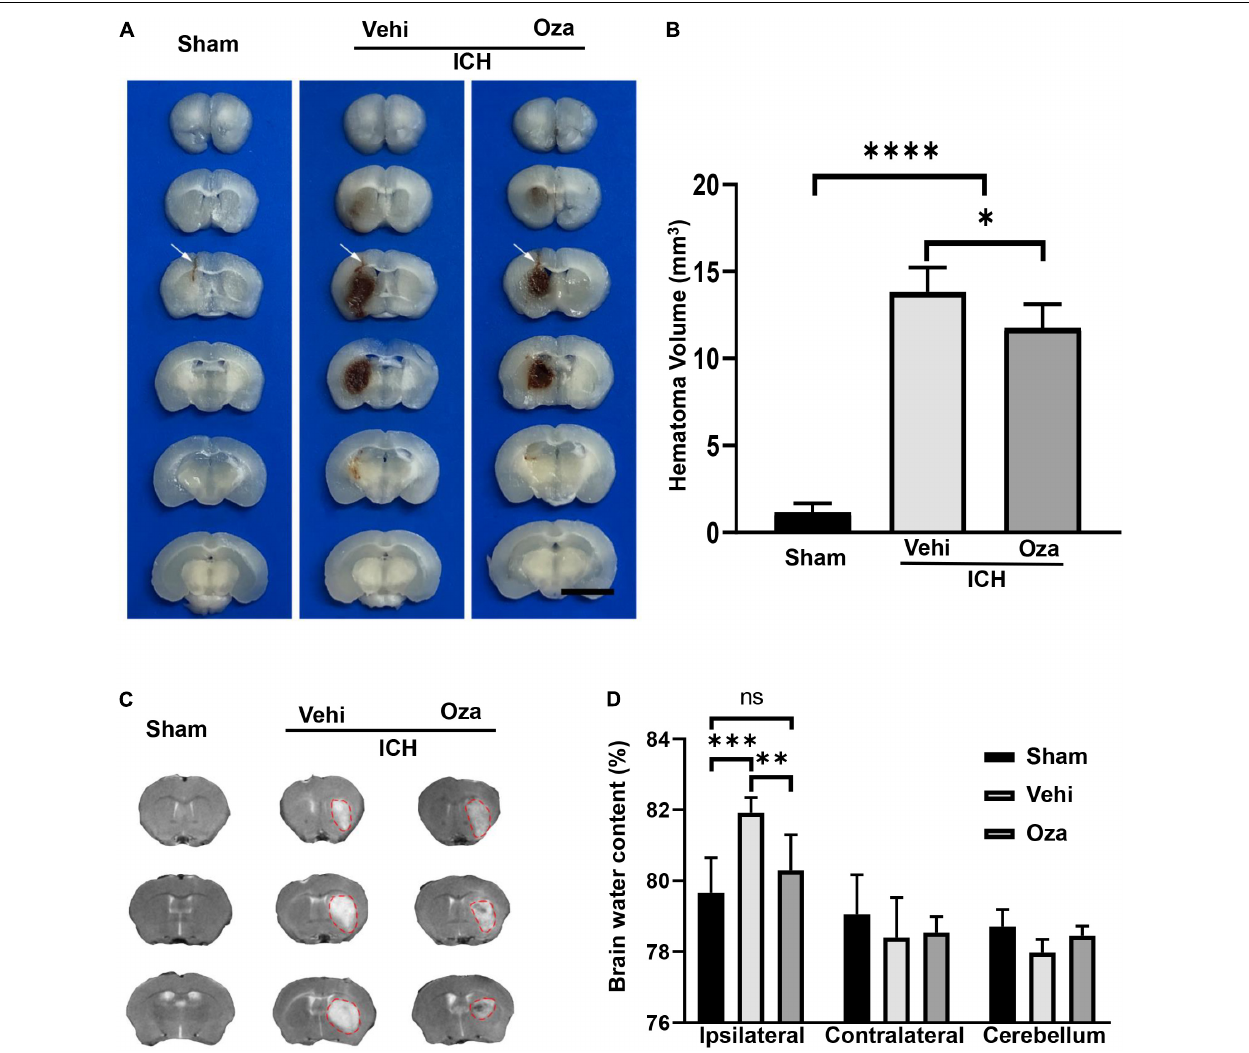
FIGURE 2 | The effects of Ozanimod on hematoma volume and brain edema in mice at 3 days after ICH. (A) The arrow shows the pinhole (Bar = 5 mm). (B) The volume of hematoma was reduced in the Ozanimod group compared to the vehicle group ( n = 8). (C) Representative MRI images of ICH before and after Ozanimod treatment. (D) Ipsilateral brain water content ( n = 6). Data are presented as mean ± SD . ∗ p < 0.05, ∗∗ p < 0.01, ∗∗∗ p < 0.001, ∗∗∗∗ p < 0.0001.